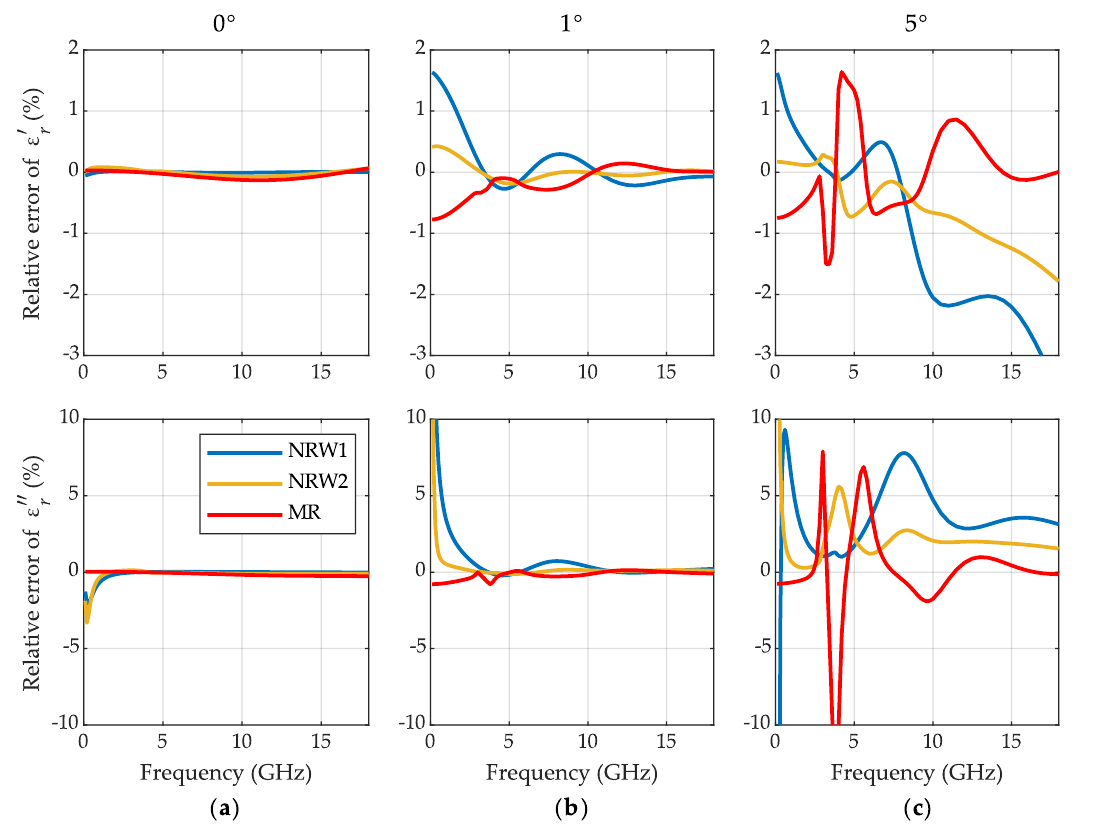
Figure 10. The relative error of the real ( ε (cid:48) r ) and imaginary ( ε (cid:48)(cid:48) r ) part of permittivity for distilled water for ( a ) the perfectly vertical cell position, ( b ) 1° and ( c ) 5° tilted cell. Line colors: red—the outcome of the meniscus removal (MR) method, blue and yellow—the NRW method for the initial and the final volumes of liquid, respectively.